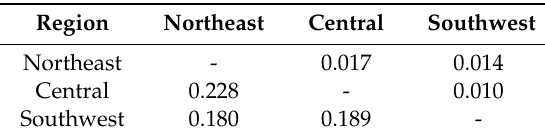
Table 4. Pairwise genetic di ff erentiation (lower left: G ST , upper right: Jost’s D) among three regions of Sclerolaena napiformis from Victoria and New South Wales, Australia. We report the greatest di ff erence occurring between central and northeast